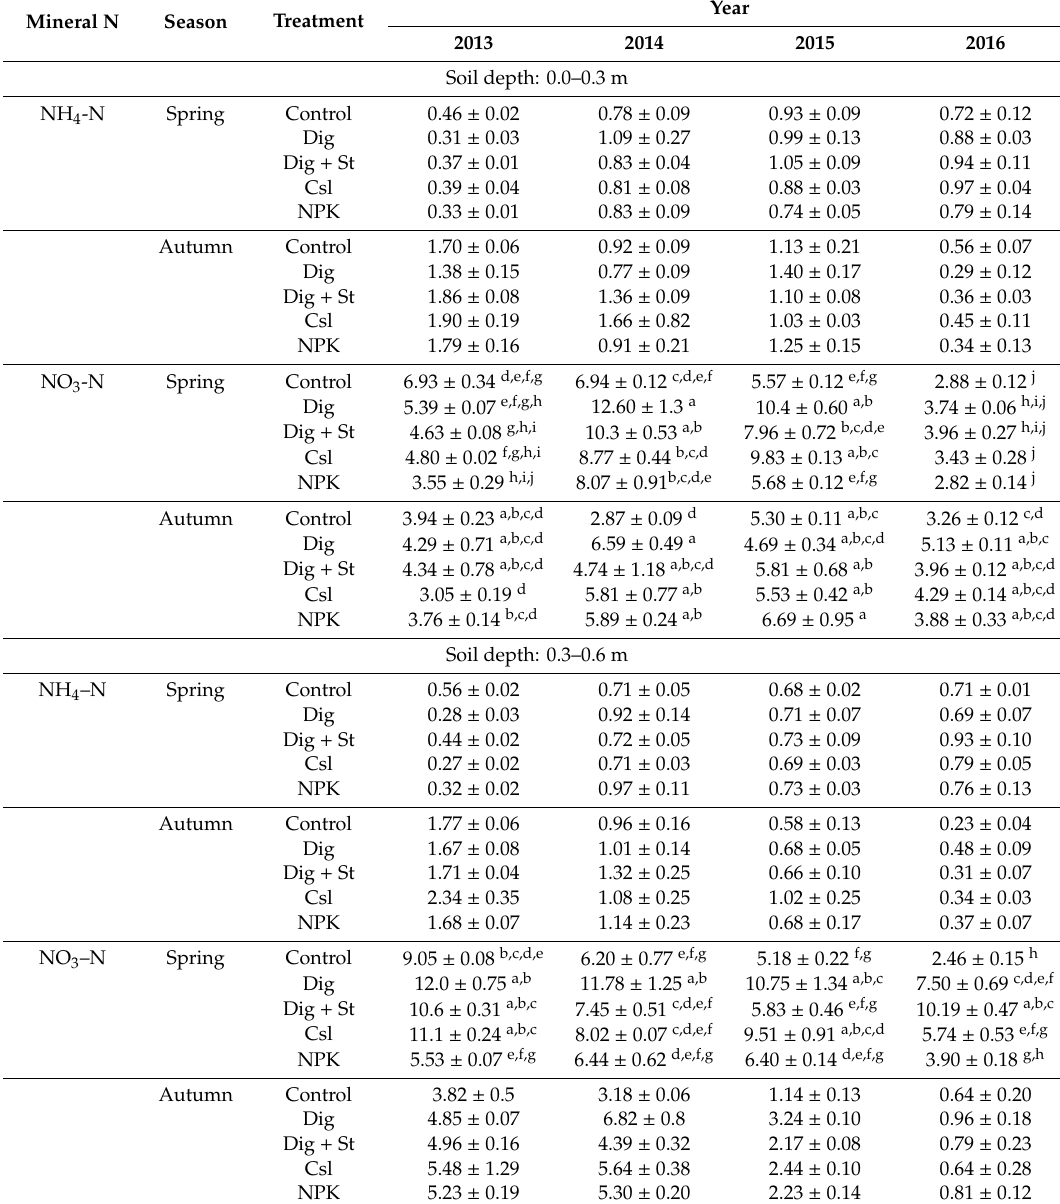
Table 6. Mineral nitrogen forms (NH 4 -N and NO 3 -N) in soil samples (mg kg − 1 ) as a result of interaction between year and fertilizer treatment in spring and